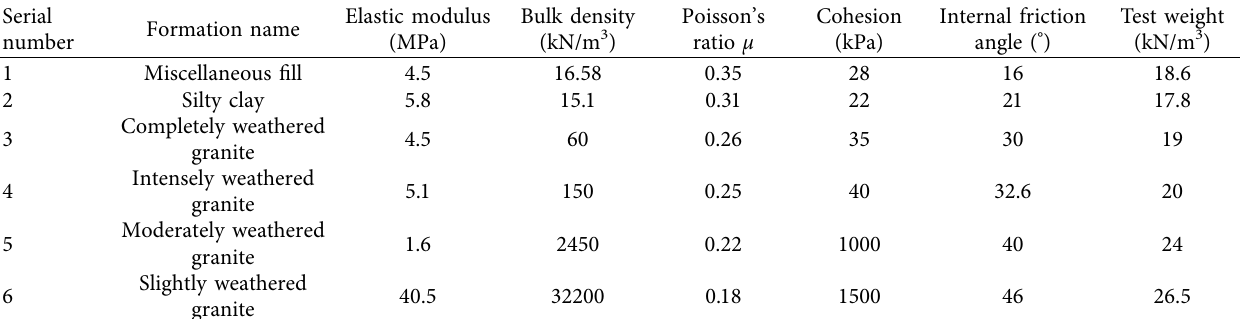
Figure 2: Numerical model. Table 1: Physical and mechanical parameters of rock and soil layer.